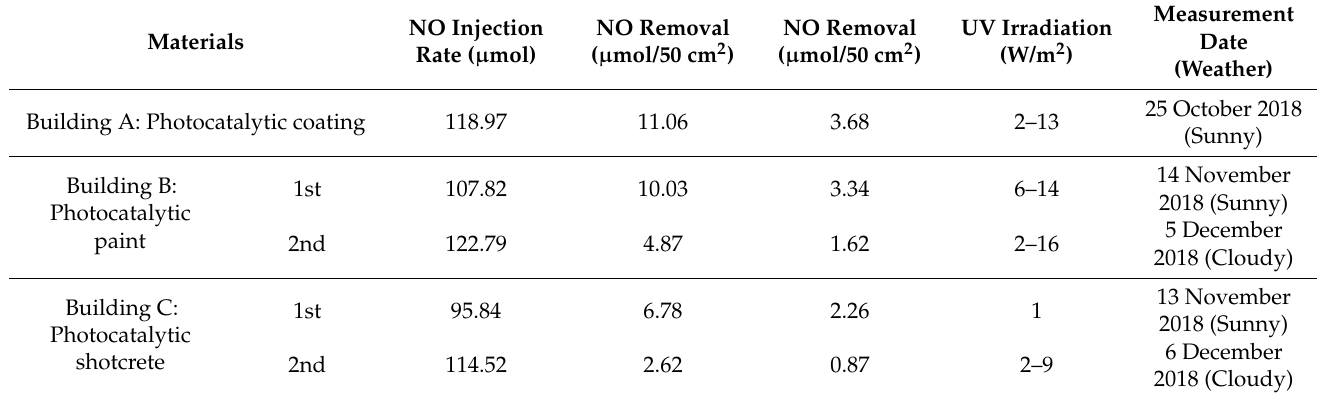
Table 7. Outdoor NO removal results for construction materials.